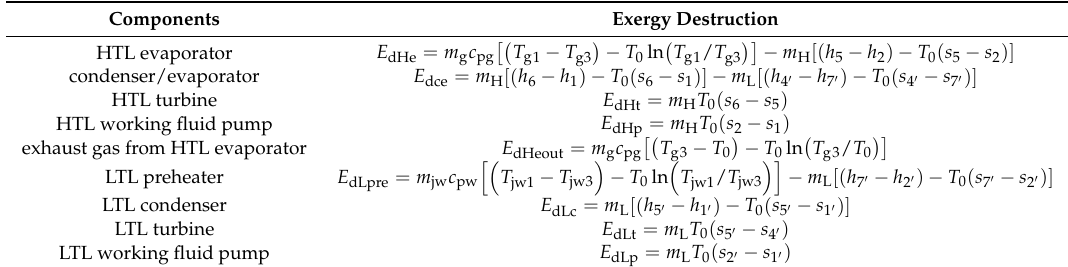
Table 2. Calculation formulation of exergy